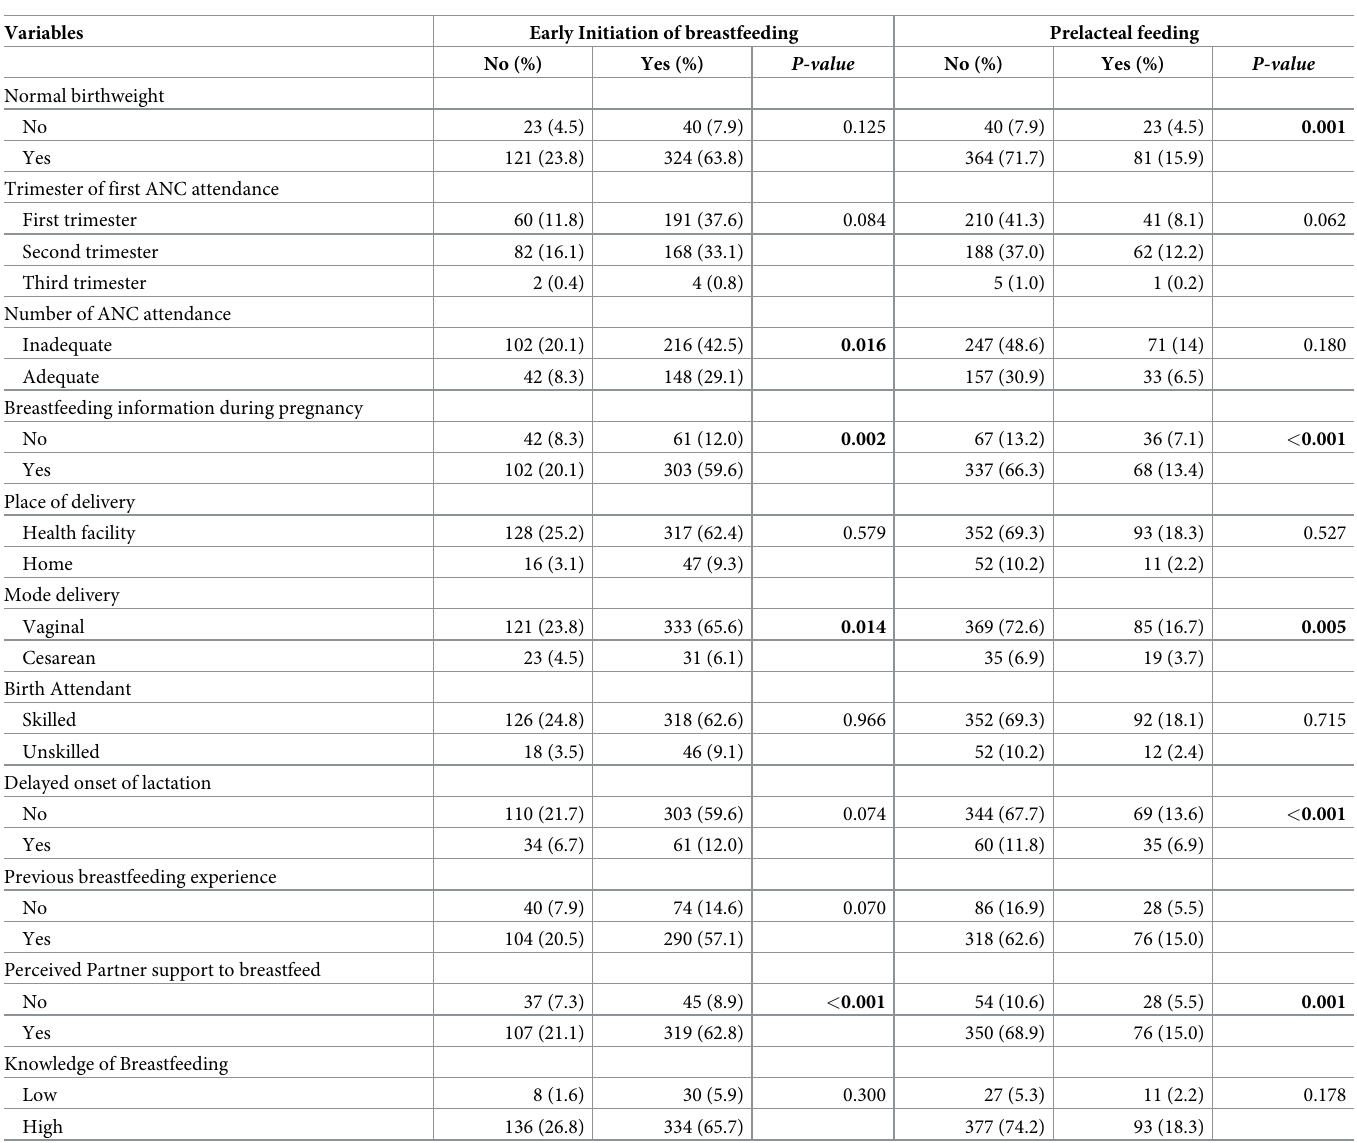
From model 2 in Table 2, multivariate logistic regression analysis revealed birthweight, exposure to breastfeeding information, and delayed lactation onset as predictors of prelacteal feeding practice. Prelacteal feeding practice was less likely among mothers with normal weight babies [AOR = 0.48 (95% CI: 0.27–0.87)], and mothers who received breastfeeding informa- tion during pregnancy [AOR = 0.46 (95% CI: 0.28–4.17)]. Risk factor for prelacteal feeding practice was experiencing delayed onset of lactation [AOR = 2.52 (95% CI: 1.52–4.17)]. Discussion The prevalence of EIBF was 72%, higher than that of the 2014 GDHS (56%) [10] and 2017/ 2018 Ghana multi indicator Survey (MICS) (52%) [14]. The differences may be due to